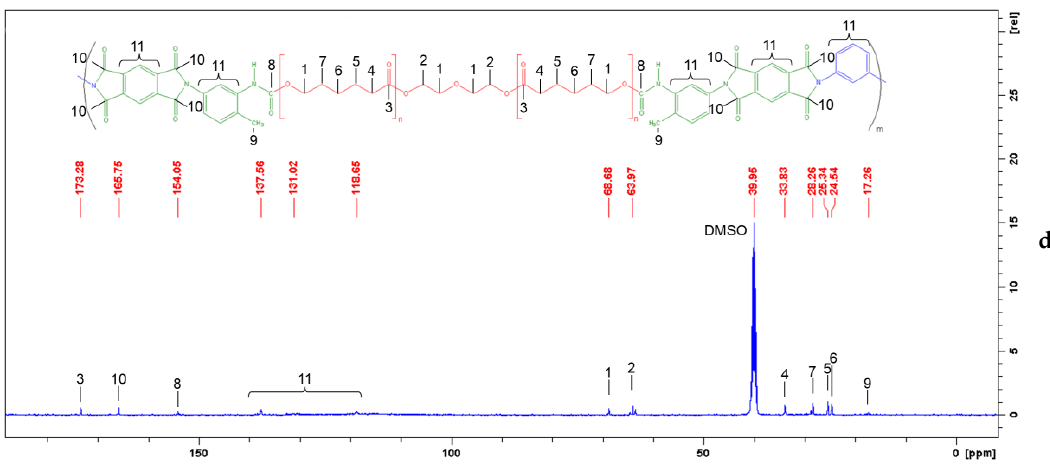
Figure 5. 1 H ( a , b ) and 13 C ( c , d ) NMR spectra of the segmented PUIs based on polycaprolactone (PCL) with a molecular weight of 530 ( a , c ) and 2000 ( b , d ).